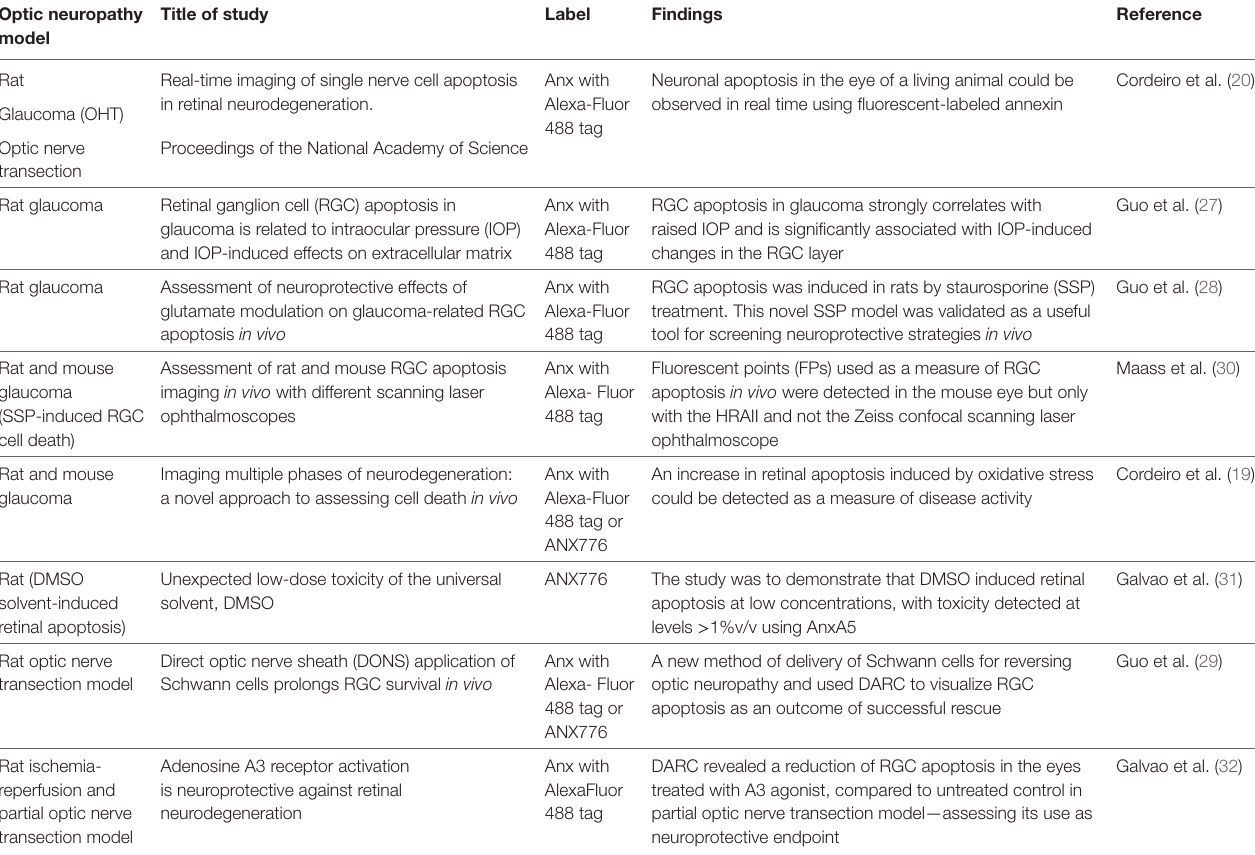
TABLe 1 | Summary of previous studies showing the use of